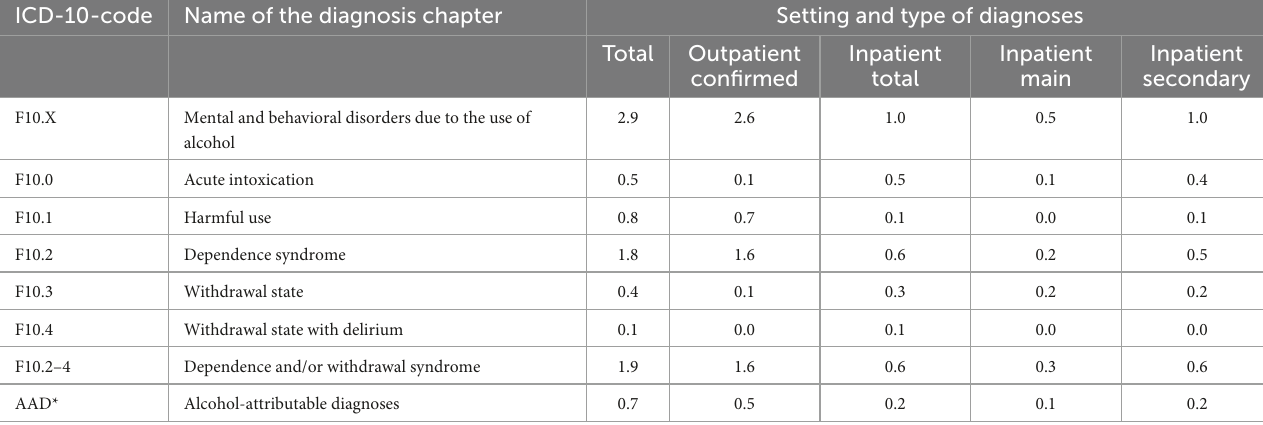
TABLE 2 Administrative prevalence (%), stratified by diagnosis’ setting and type, in the statutory health insurances’ (SHIs) population in Bremen in 2016/2017.